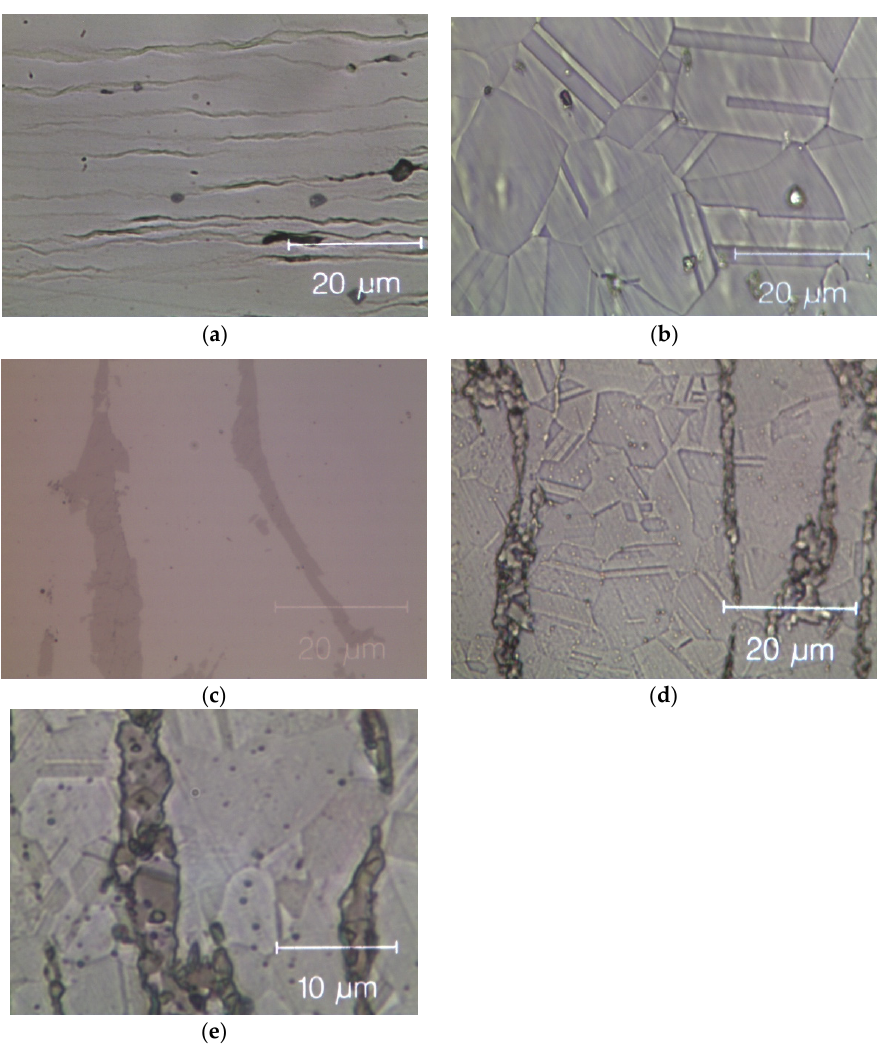
Figure 8. Optical microscope images of the Zr-free and Zr-modified HEA. ( a ) Zr-free after cold rolling; ( b ) Zr-free after recrystallization; ( c ) Zr-modified after cold rolling and ( d ) Zr-modified after recrystallization; ( e ) detail of Zr-modified after recrystallization: twin boundaries in the inter-dendritic phase are visible. The inter-dendritic phase is that corresponding to the dark vertical stripes in the optical image ( c – e ).